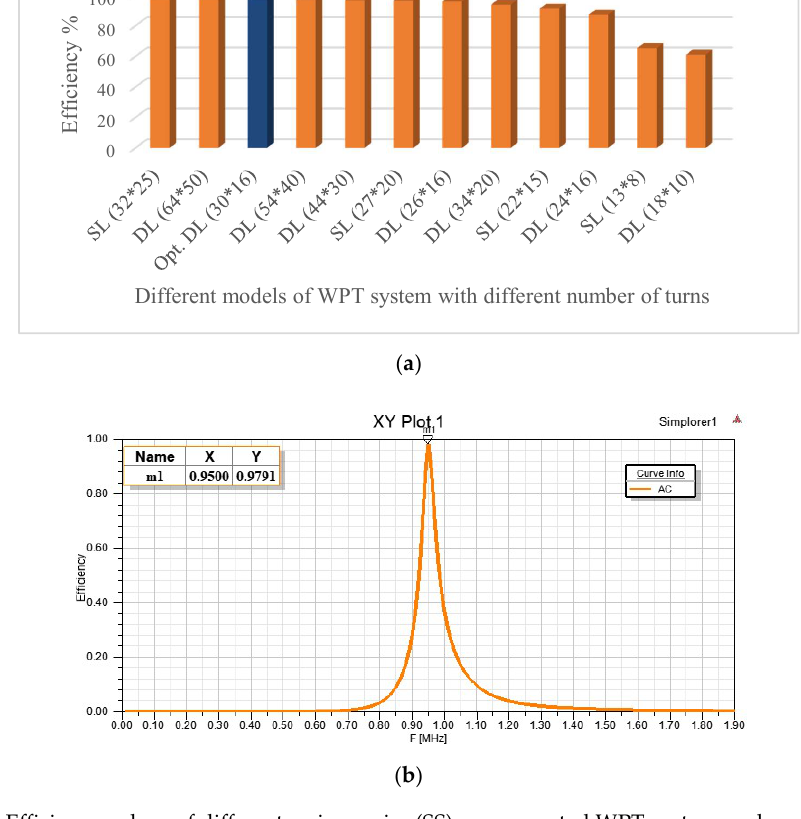
Figure 6. E ffi ciency values of di ff erent series–series (SS)-compensated WPT systems, where the chosen model is marked in blue. ( a ) Di ff erent models of WPT system with di ff erent numbers of turns. ( b ) E ffi ciency of chosen design DL (30,